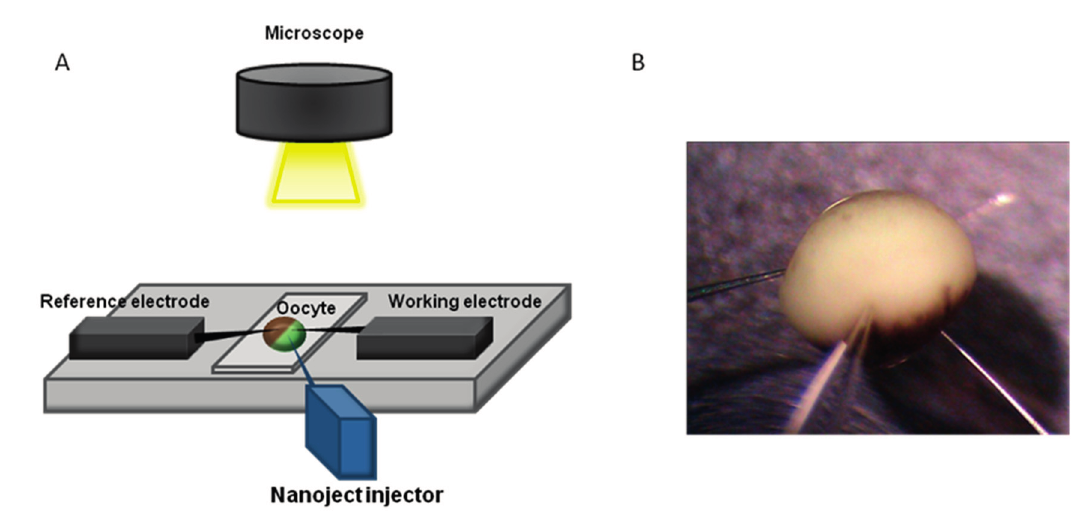
Figure10. Experimental setup for simultaneous test solution injection and potentiometric measurements, ( A ) Schematic illustration of the setup and ( B ) Photography of Xenopus oocyte penetrated by the reference electrode (left), measurement electrode (right), and injector (middle).